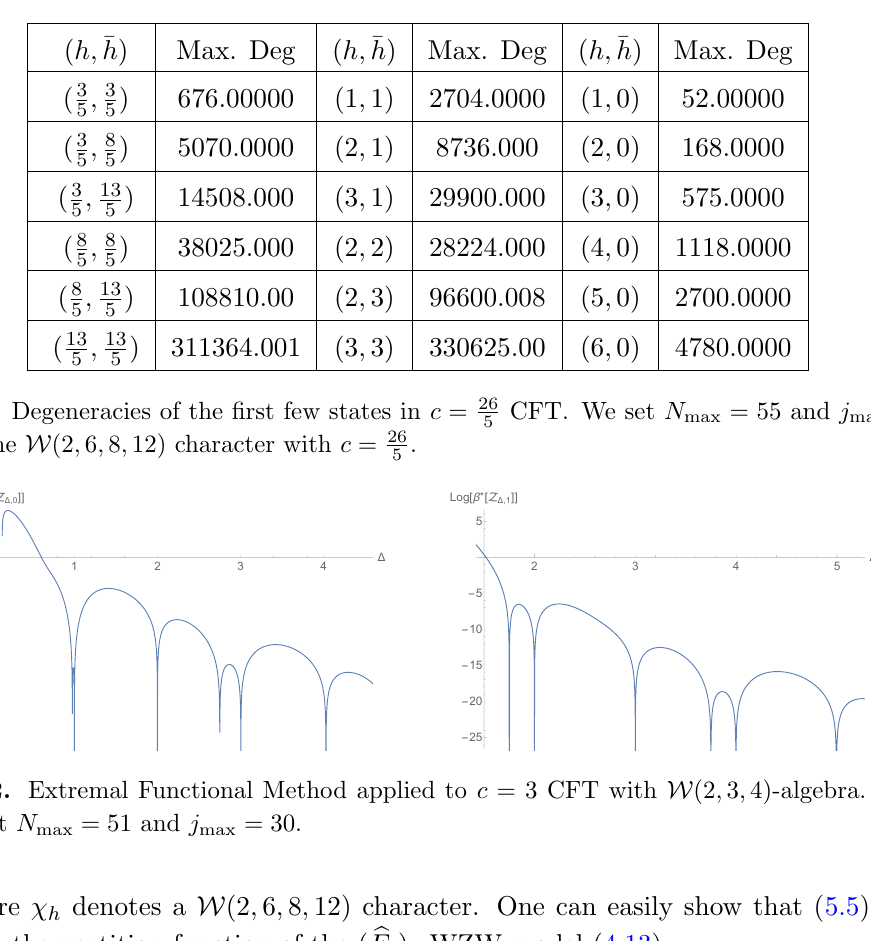
Figure 21. The Extremal Functional Method applied for W (2 ; 6 ; 8 ; 12), c = 26 N max = 51 and j max = 30. The left (cid:12)gure is the spin-0 sector, while the right one is the spin-1 sector.